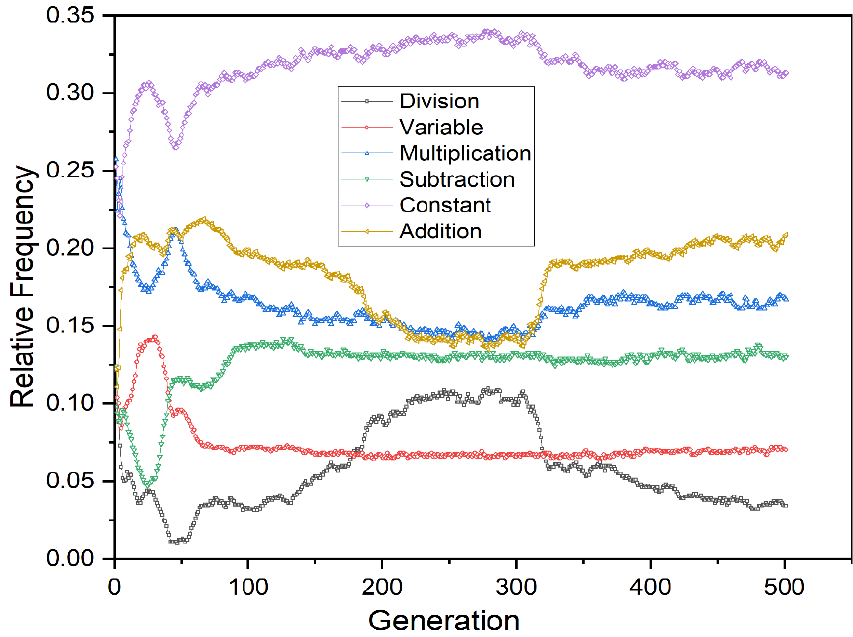
Figure 3. Relative occurrence frequency of various functions and terminals in GP trees over 500 generations.